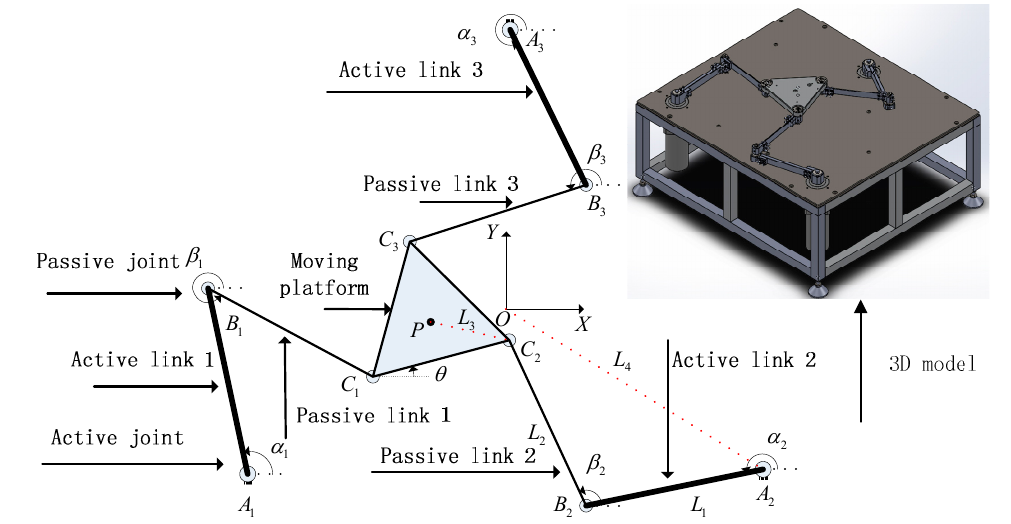
Figure 2. Sketch of the 3 ‐ DOF flexible parallel robot mechanism.